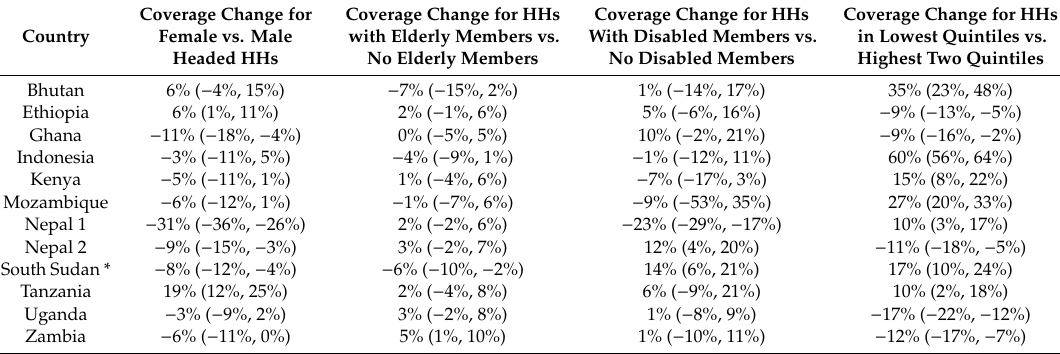
Table A3. The di ff erence-in-di ff erence of basic sanitation coverage comparing vulnerable and non-vulnerable groups. Coverage Change for HHs Coverage Change for HHs Coverage Change for HHs Coverage Change for in Lowest Quintiles with Elderly Members vs. With Disabled Members vs. Country Female vs. Male No Disabled Members No Elderly Members Headed HHs